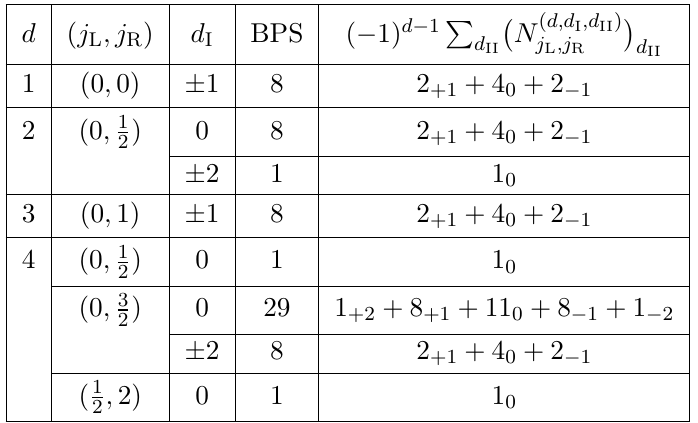
Table 2 . The split of the BPS indices on the D 5 del Pezzo curve for the (1 ; 1 ; 1 ; 1) model. The split is interpreted as the decomposition of the D 4 representations into the ( A 1 ) 4 subalgebra, as in 8 v ! ( 2 ; 2 ; 1 ; 1 ) + ( 1 ; 1 ; 2 ; 2 ), 8 s ! ( 2 ; 1 ; 2 ; 1 ) + ( 1 ; 2 ; 1 ; 2 ), 8 c ! ( 2 ; 1 ; 1 ; 2 ) + ( 1 ; 2 ; 2 ; 1 ) and 28 ! ( 3 ; 1 ; 1 ; 1 ) + ( 1 ; 3 ; 1 ; 1 ) + ( 1 ; 1 ; 3 ; 1 ) + ( 1 ; 1 ; 1 ; 3 ) + ( 2 ; 2 ; 2 ; 2 ), where the last A 1 factor contributes as the u(1) charge in the subscript (and hence is